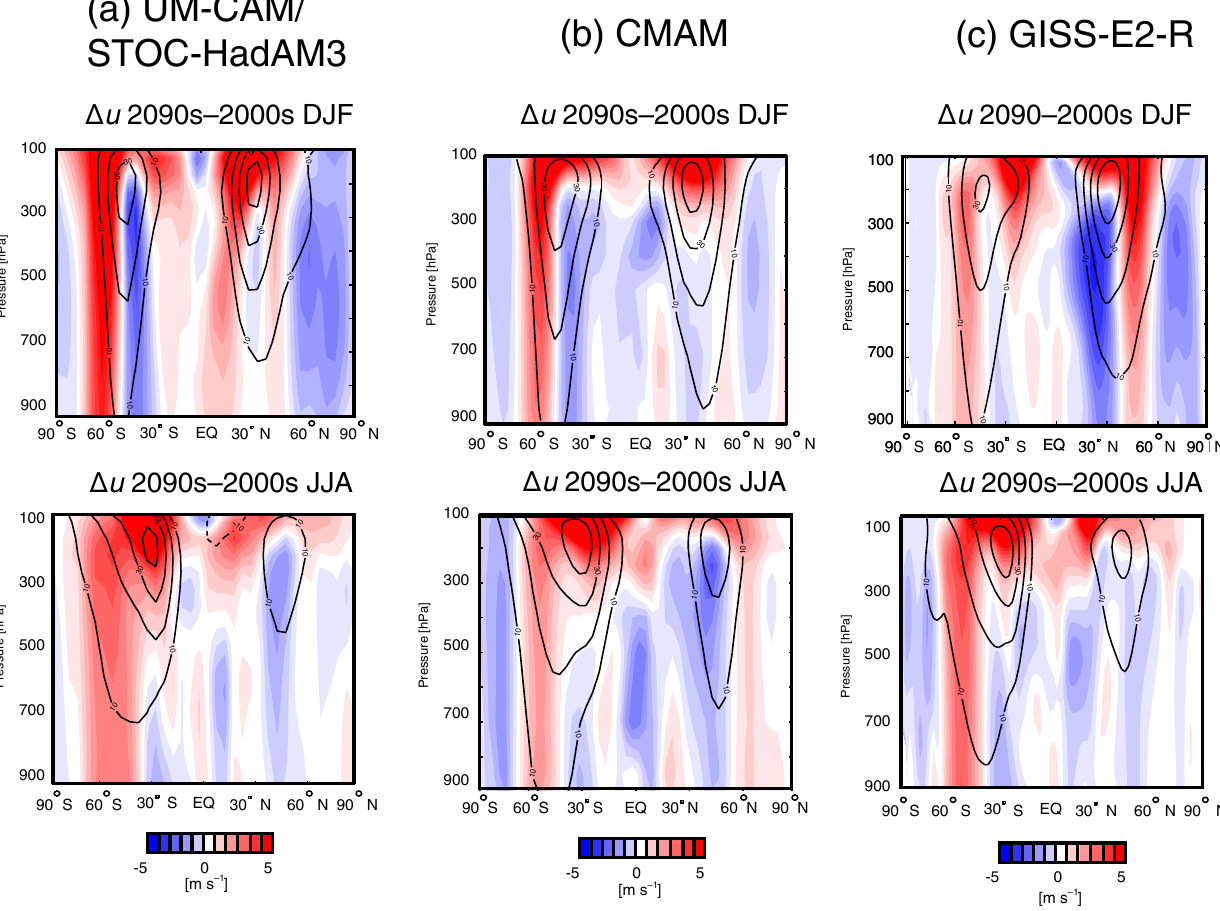
Figure 10. Zonal-mean zonal ( u ) wind differences between 2090–2099 (RCP 8.5) and 1996–2005 (present day) for DJF (top panels) and JJA (bottom panels). Results are shown for (a) UM-CAM and STOC-HadAM3 (same driving GCM), (b) CMAM, and (c) GISS-E2-R. Black contours denote the present-day